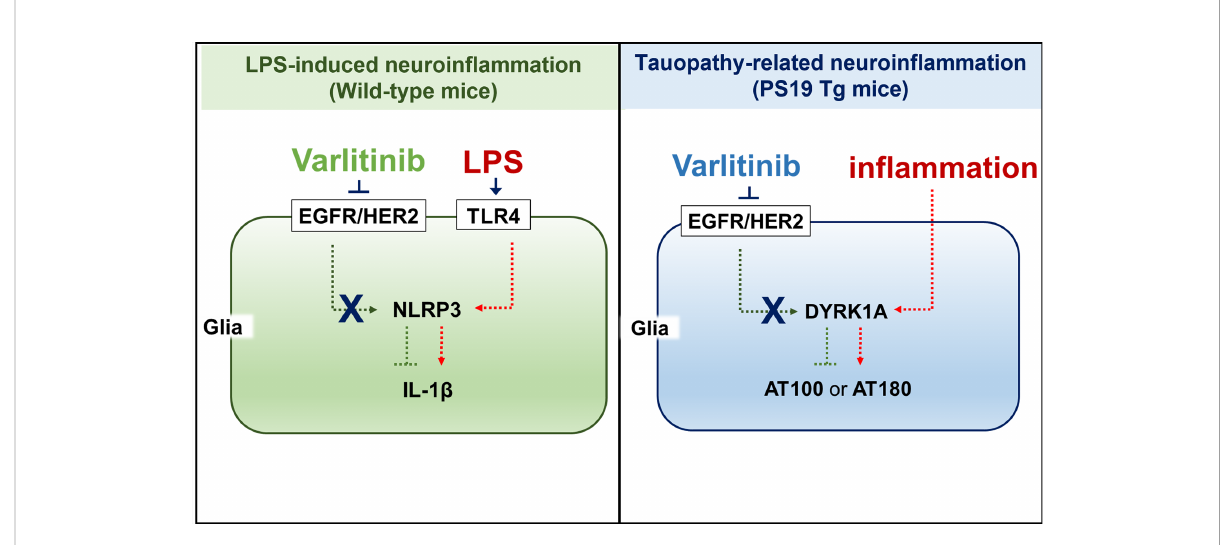
FIGURE 11 (A) working model for how varlitinib alters LPS/tau-mediated neuroin fl ammatory responses and tauopathy in vivo . In the LPS-induced model of neuroin fl ammation in wild-type mice, varlitinib inhibits EGFR/HER2 and TLR4-linked NLRP3 in fl ammasome activation, leading to suppression of LPS-induced proin fl ammatory/neuroin fl ammatory responses. In tau-overexpressing PS19 mice, varlitinib inhibits tau kinase DYRK1A activation, resulting in downregulation of neuroin fl ammatory responses and tau